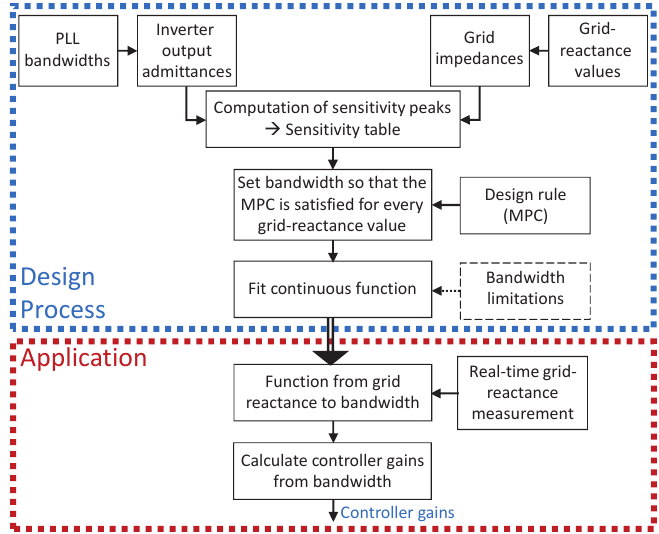
Figure 5. Flowchart of adaptive PLL design process and